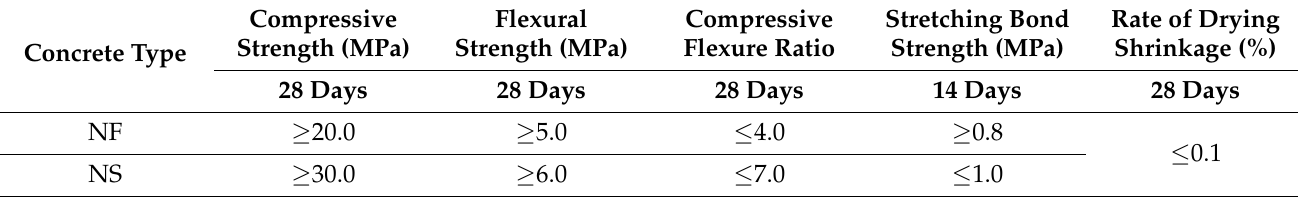
NF: normal flexible repair mortar; NS: normal stiffness repair